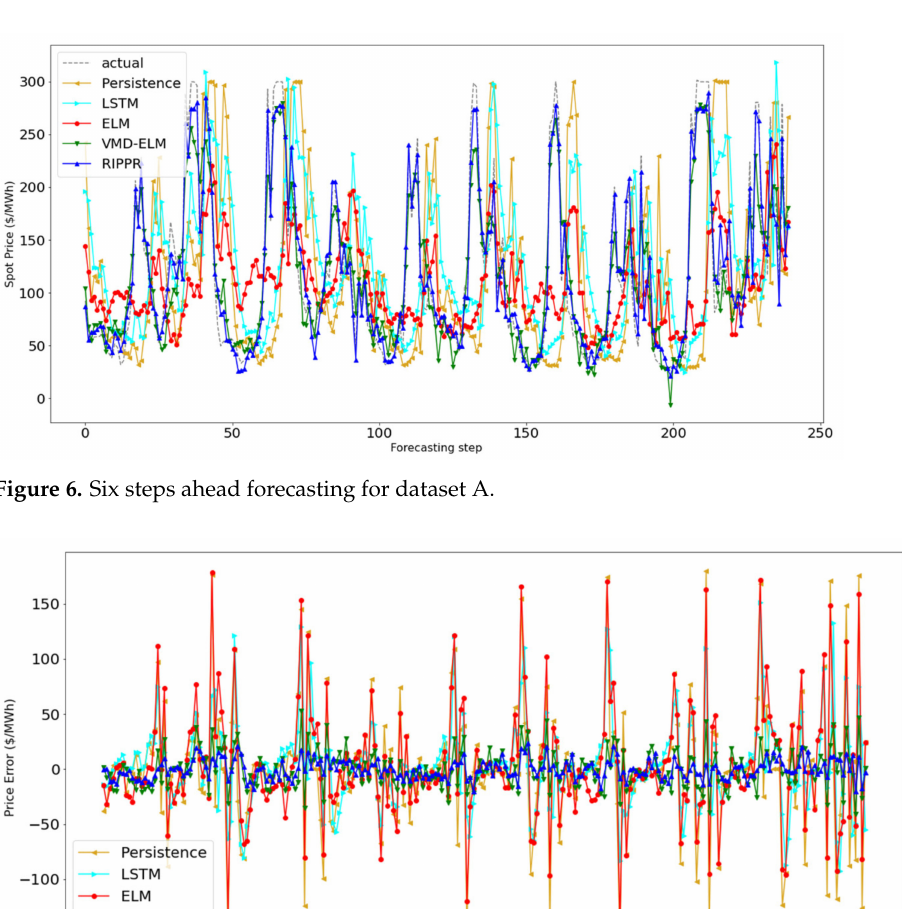
Figure 5. One step ahead forecasting for dataset A.